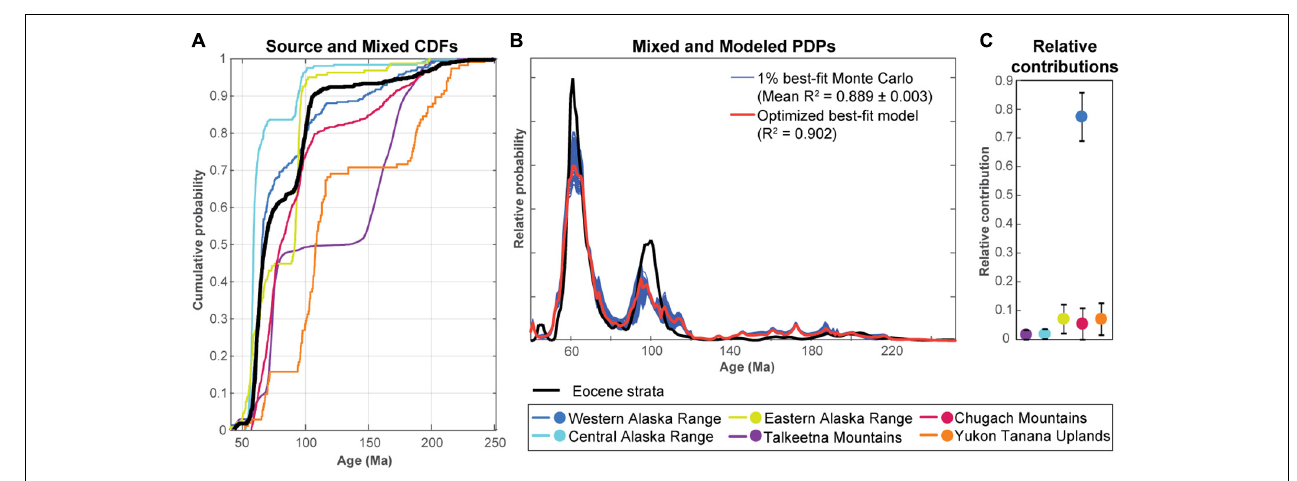
FIGURE 5 | Same as Figure 3 except for the Eocene